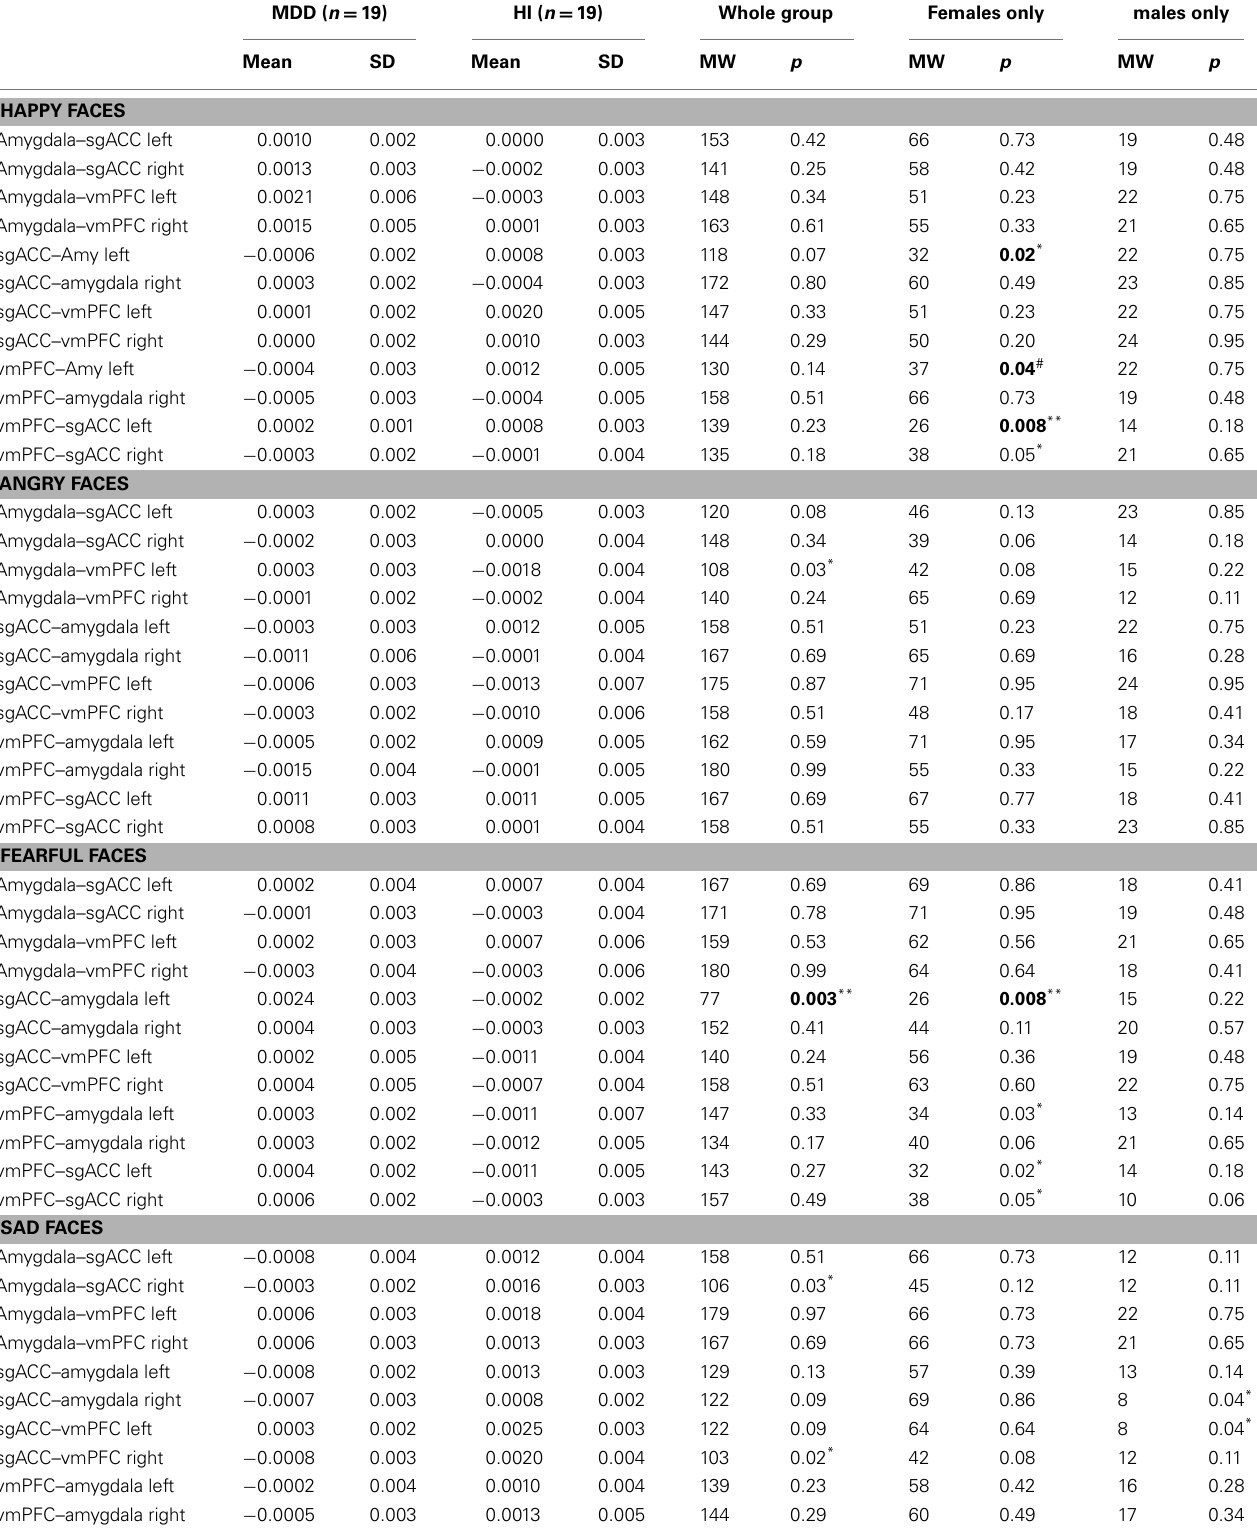
Table 4 | Effective connectivity estimates to happy, fearful, sad, and angry